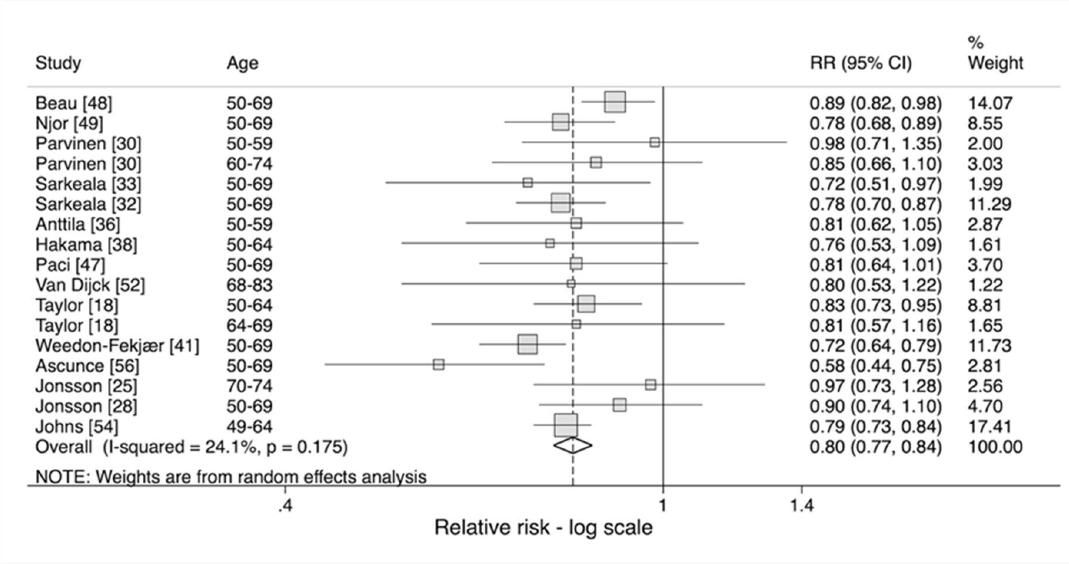
Figure 4. Effect of invitation on risk of breast cancer mortality in women aged 50 and over [18,25,28,30,32,33,36,38,41,47–49,52,54,56].